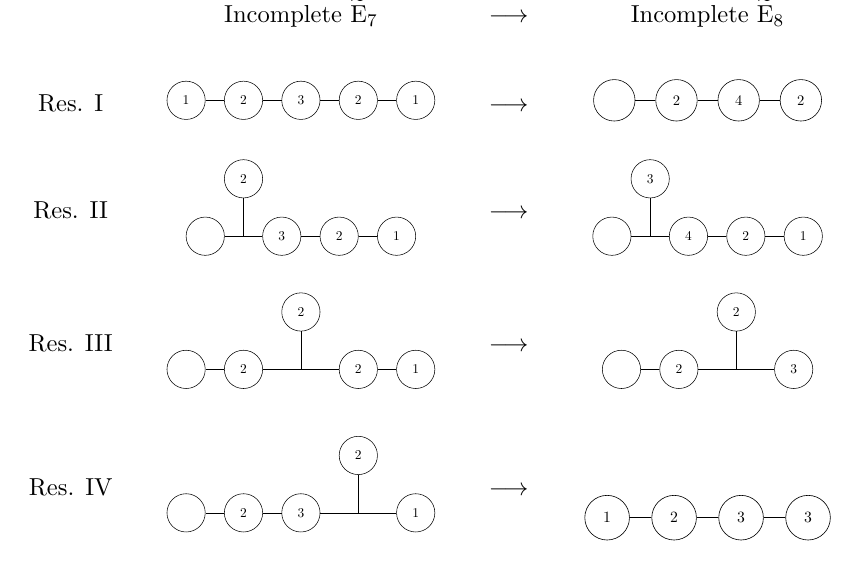
Figure 3 . Non-Kodaira Fibers for the SU(2) (cid:2) G 2 -model. On the left, we have the generic (cid:12)ber over the collision S \ T . On the right, we have its specialization when f = 0. This specialization is seen only when the base is at least a threefold or if we change the valuation of t along a 4